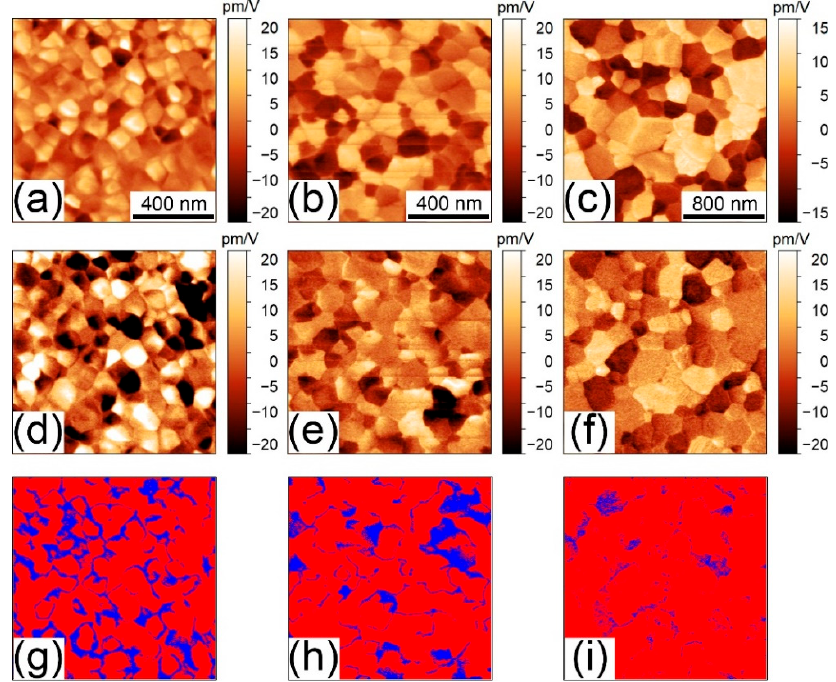
Figure A3. PFM images and phase distribution images in: ( a , d , g ) one-layer; ( b , e , h ) three-layer; ( c , f , i ) 15-layer LTD BFO films. ( a – c ) Vertical PFM images; ( d – f ) lateral PFM images; ( g – i ) distribution of the piezoelectrically active (red) and non-active (blue)